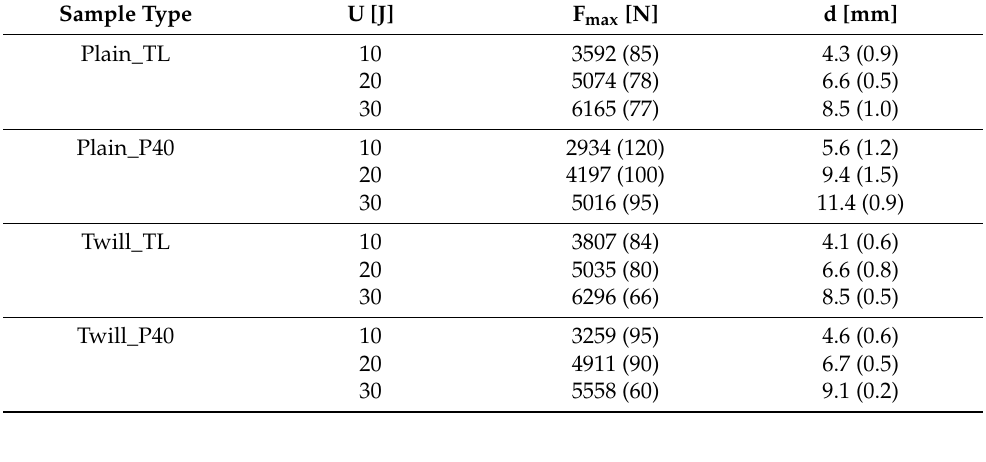
Polymers 2021 , 13 , 1055 10 of 13